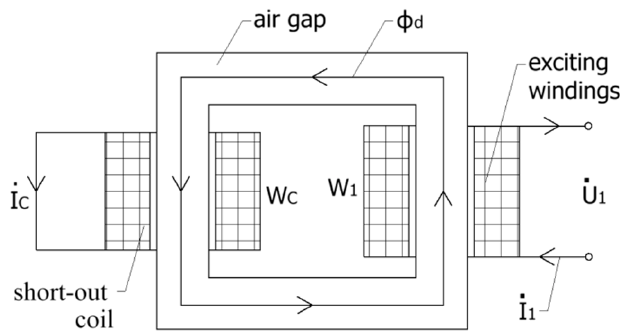
Figure 3. The secondary winding as a single turn short-cut coil.